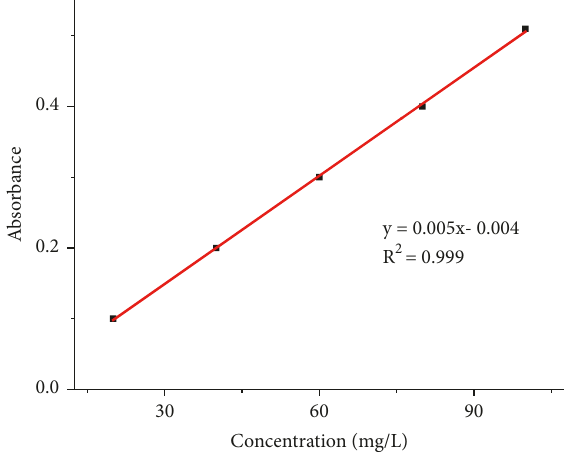
Figure 3: Plot of absorbance of FCR in the presence of various concentrations of gallic acid.